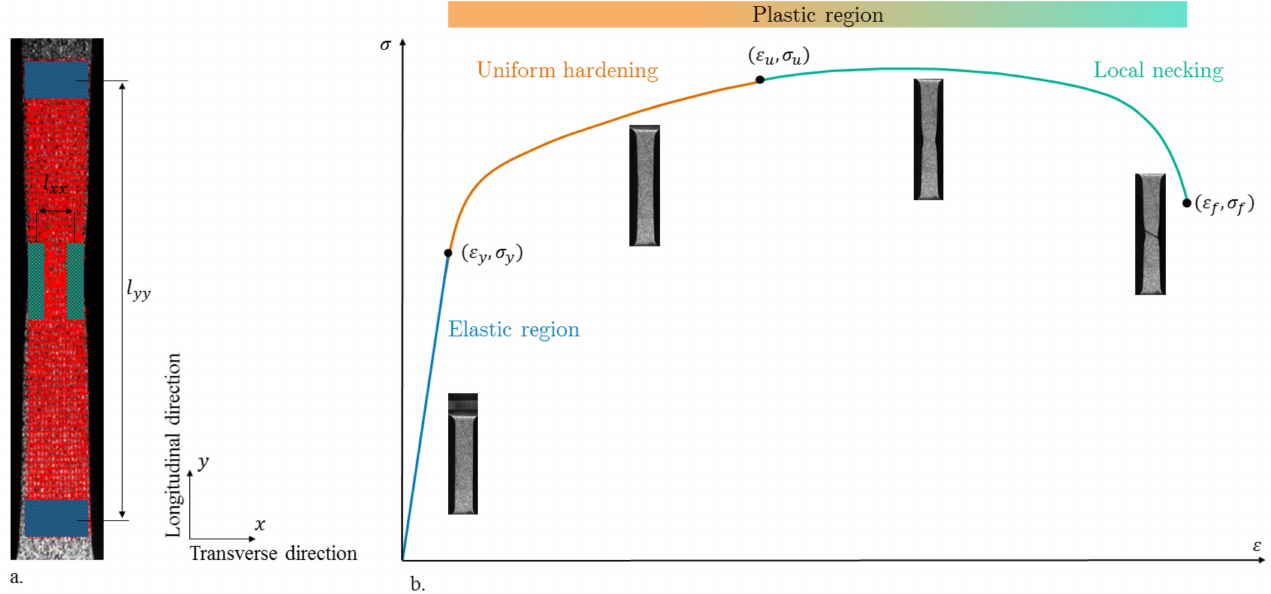
Figure 2. ( a ) Image analysis of the tensile test specimens. ( b ) Strain–stress curve of the grade 2 titanium. Longitudinal strains (on the y-axis) were computed using the five upper and five lower ranges of grid points. Transverse strains were computed using the two right and two left columns of grid markers in the necking